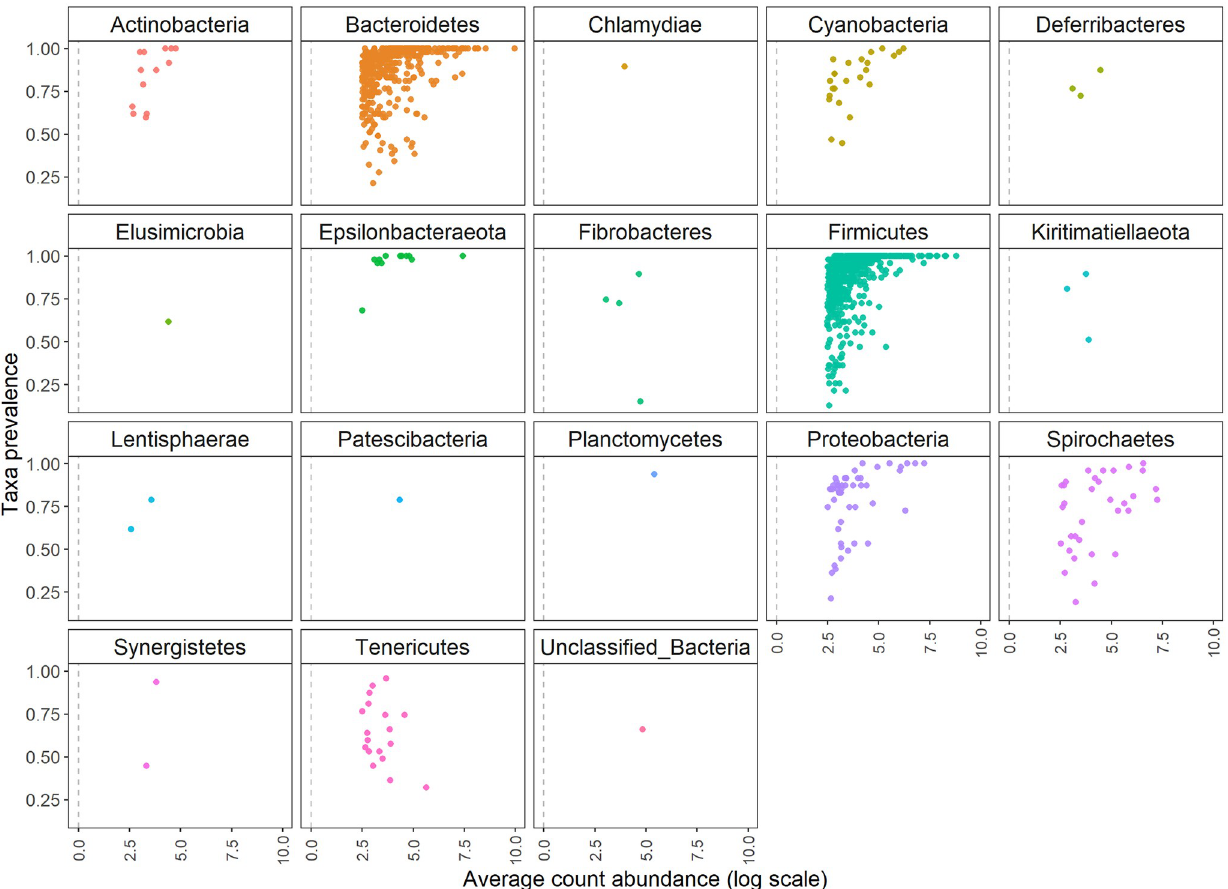
Fig 1. Phyla prevalence and abundance in dataset. Each dot represents an OTU, being the x-axis its average relative abundance and the y-axis the proportion of samples in which it is present. “Unclassified_Bacteria” is the denomination given to those OTUs with no phylum assignment.